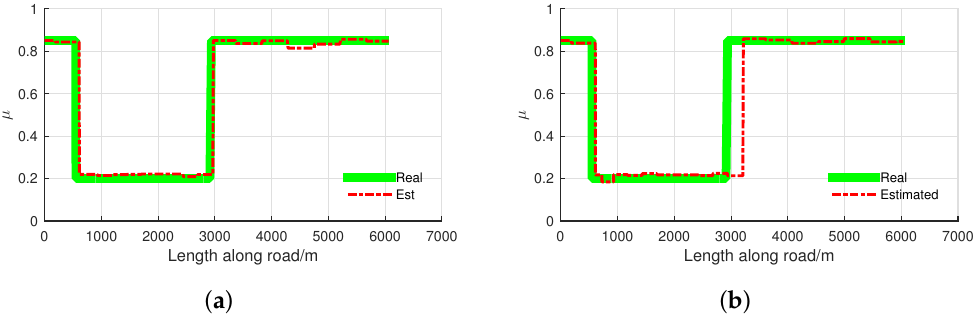
Figure 28. Estimated friction coefficients: ( a ) Controller A + ISPFCE and ( b ) Controller B + ISPFCE.